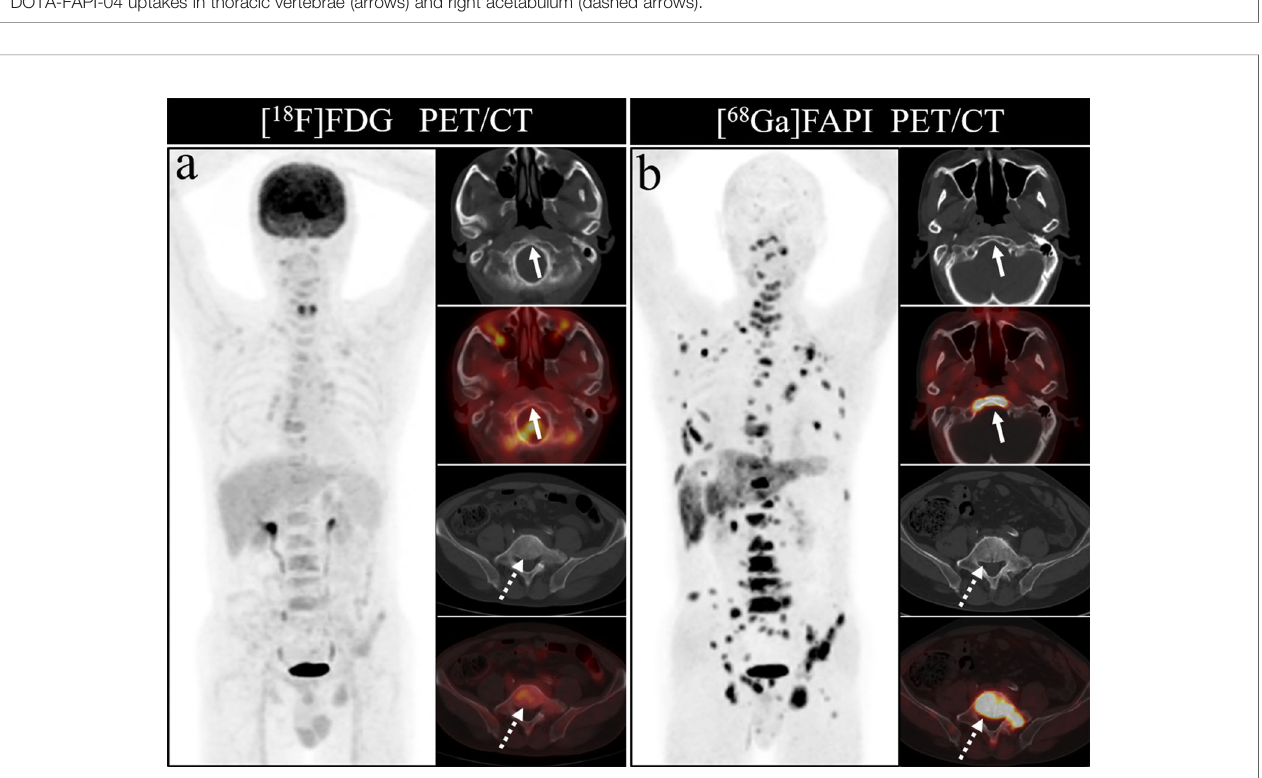
FIGURE 4 | A 63-year-old man was received [ 18 F]FDG and [ 68 Ga]Ga-DOTA-FAPI-04 PET/CT (A, B) to evaluate the new diagnosed lung cancer. The MIP image (A, B) of [ 18 F]FDG and [ 68 Ga]Ga-DOTA-FAPI-04 PET/CT demonstrated multiple bone lesions. On the selected axial images, [ 18 F]FDG PET/CT (A) only showed slight [ 18 F]FDG activities in the clivus (arrows) and lumbar vertebral (dashed arrows). On the contrary, intense FAPI uptakes in the clivus (arrows) and lumbar vertebral (dashed arrows) were obviously observed on [ 68 Ga]Ga-DOTA-FAPI-04 PET/CT.